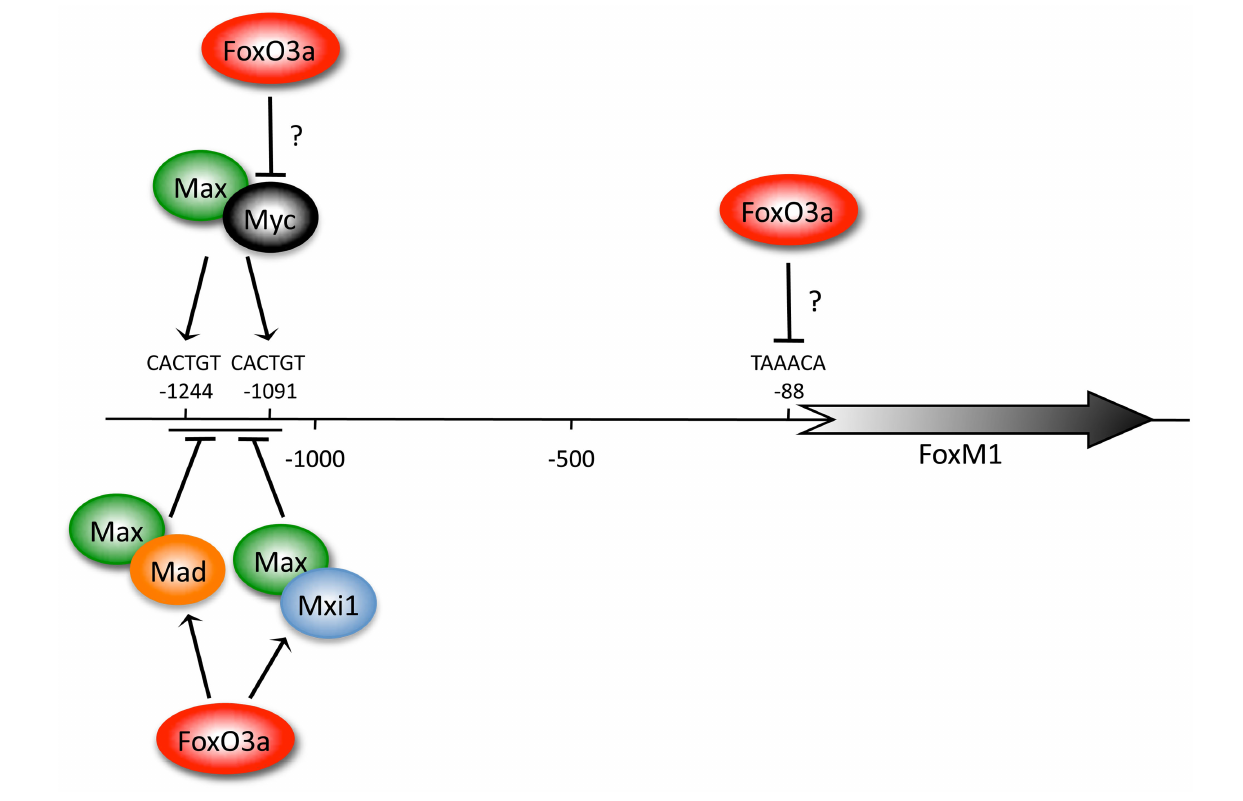
FIGURE 1 | FoxM1 expression is repressed by FoxO3a. FoxO3a may repress FoxM1 expression in one of three ways, which may not be mutually exclusive. First, FoxO3a may bind to a Fox consensus site at position − 88 of the FoxM1 promoter.This could lead to FoxM1 repression. Second, expression of the Myc antagonists Mad and Mxi1 are driven by FoxO3a. Mad and Mxi1 compete with Myc to dimerize with Max.The Max/Myc dimer binds to E-boxes (CACTGT) located within the FoxM1 promoter to drive FoxM1 expression, while Mad/Max